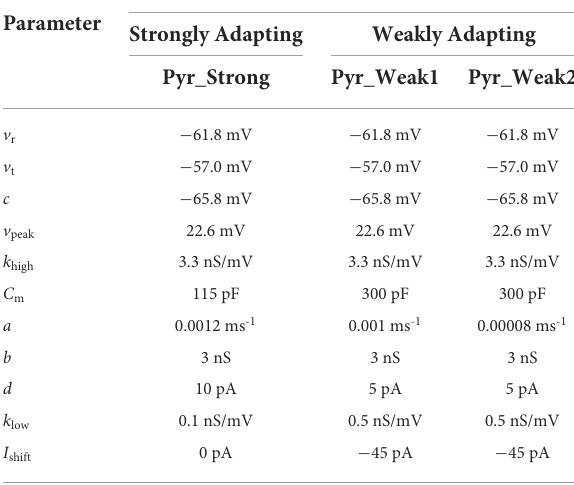
Note that the parameters C m , a , d , k low , I shift differ between the strongly adapting and weakly adapting models. Only the parameter a varies between the two weakly adapting